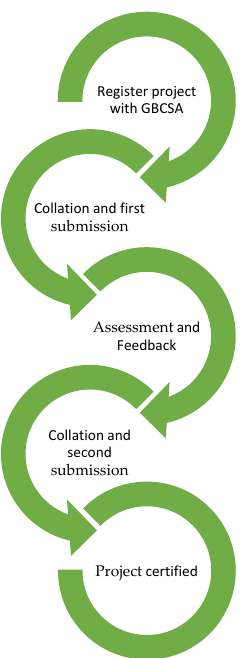
Figure 4. The GBCSA process in achieving certification.